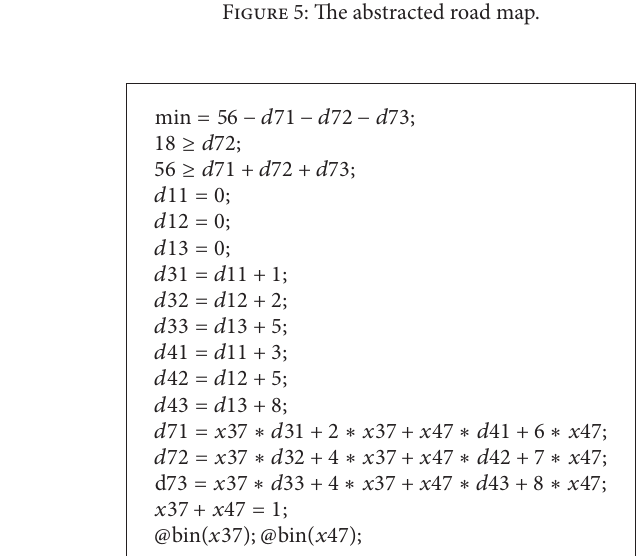
Figure 5: The abstracted road